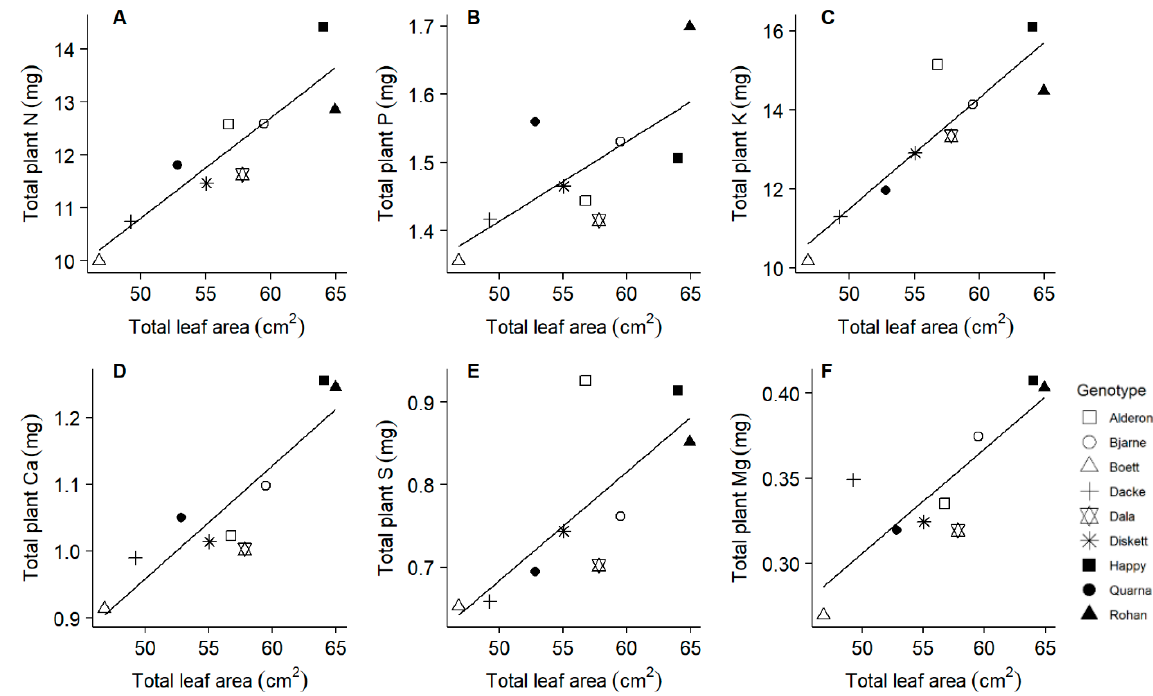
Figure 5. Relationships between total leaf area and the pools of macronutrients in whole plants at day 20. Total leaf area was measured destructively with an area meter at day 20. Linear regressions: ( A ) r 2 = 0.810, p < 0.001; ( B ) r 2 = 0.498, p = 0.034; ( C ) r 2 = 0.814, p < 0.001; ( D ) r 2 = 0.812, p < 0.001; ( E ) r 2 = 0.586, p = 0.016; ( F ) r 2 = 0.718, p = 0.004.